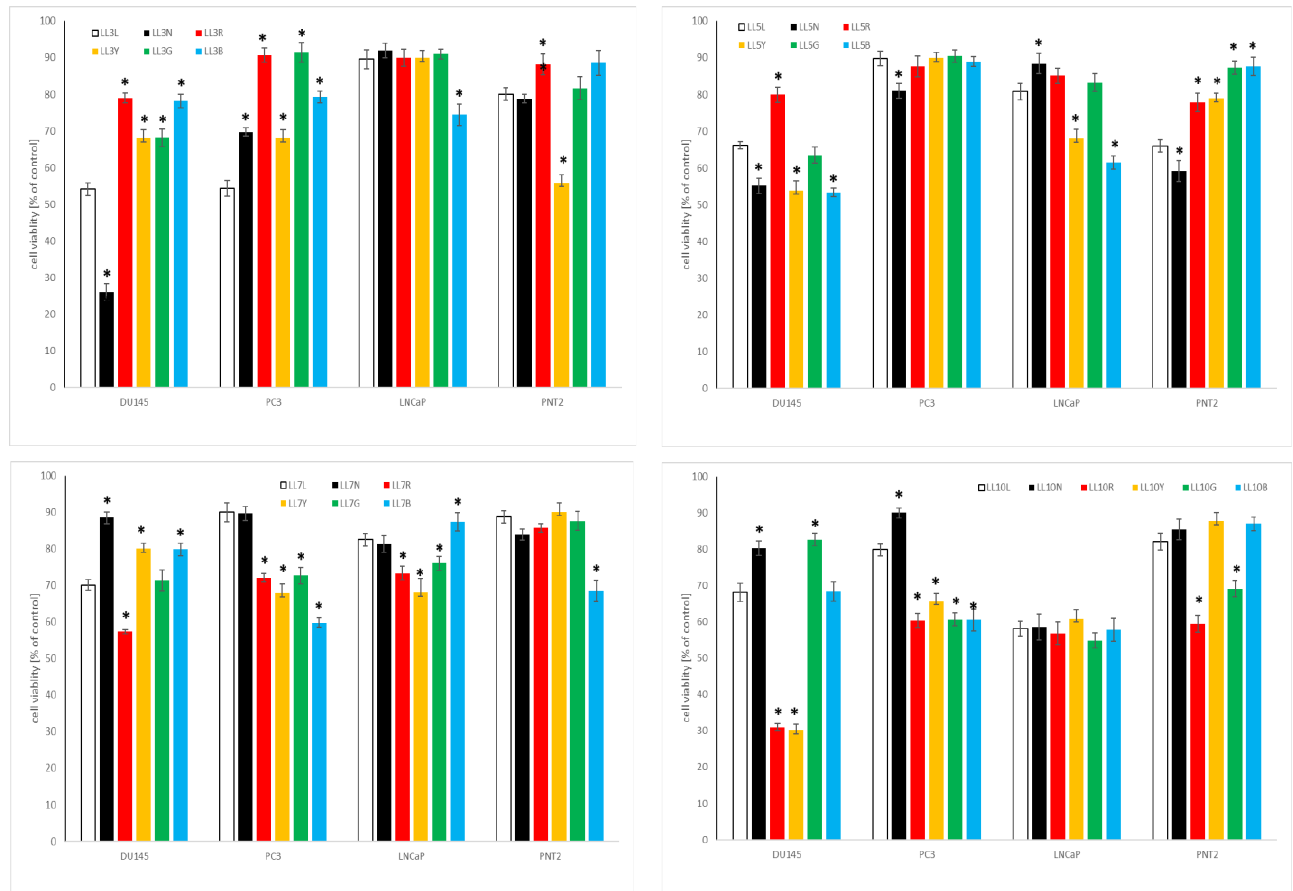
Figure 6. Cytotoxic effect of the extracts of lupin sprouts (LL) harvested for 3, 5, 7, and 10 days in different LED light conditions: natural (L), darkness (N), red (R), yellow (Y), green (G), blue (B) to prostate normal (PNT2) and cancer (DU145, PC3, LNCaP) cells. Cells were treated with 500 µg/mL of sprout extracts (n = 3) for 24 h. Values are presented as the mean ± SD (standard deviation). Significant differences ( p < 0.05) for each cell line refer to normal sprouts harvesting procedure and are marked as *. Table 4. Correlation weights for the pairs of parameters based on the PLS model. Pairs of Correlated Parameters Correlation Weights Chickpea